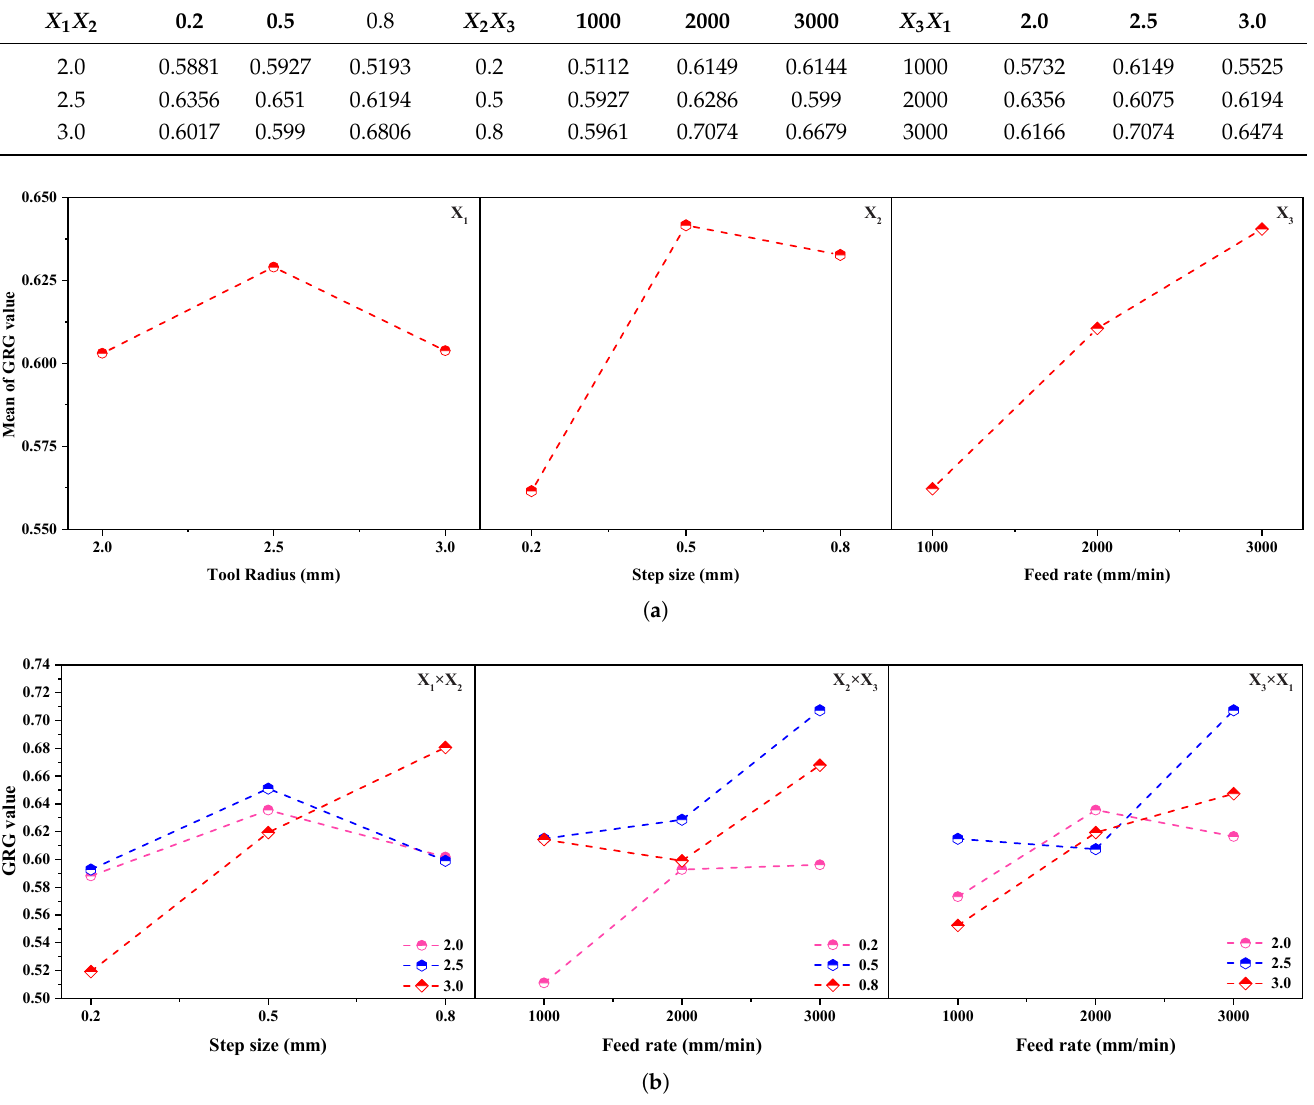
Figure 11. Process parameters vs. GRG values: ( a ) main effects; ( b ) interaction effects. The interaction plots are used here to represent how the relationship between one process parameter and a response variable, the mean GRG value, depends on the second process parameter value. The computed GRG values are summarized in Table 11. For ex- ample, Figure 11b displays the mean GRG for the levels of one process parameter on the x -axis and a separate line for each level of another process parameter. The plotted lines in Figure 11b were evaluated in detail to explain and understand how the interactions affect the relationship between the input factors and the response (mean GRG value). The plotted lines can be interpreted using two options: parallel lines, which mean